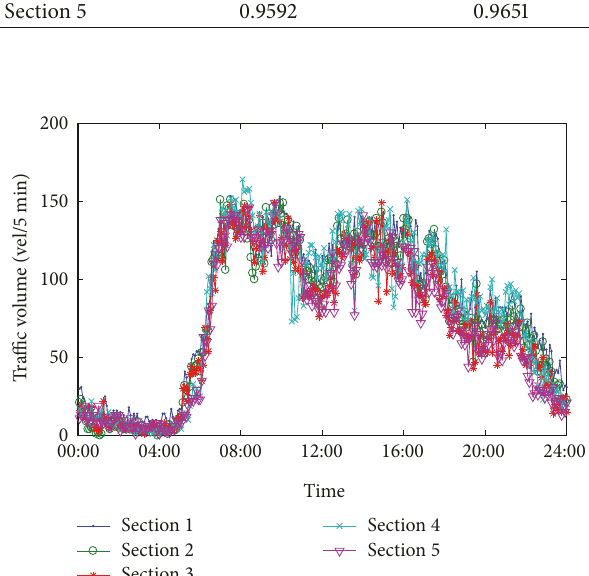
Figure 9: Traffic volume data from several adjacent lanes in a section of the urban expressway. Table 9: Correlation coefficient matrices of two traffic volume series from several adjacent lanes in a section of the urban